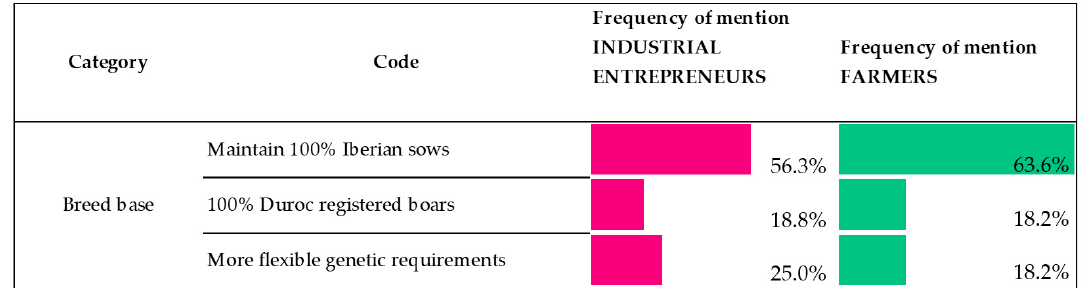
Figure 2. Industrial entrepreneur/farmer views on the requirements of the QS in terms of breed base. (Scale: frequency of mention of each opinion. Percentage is based on responses in the given code out of all responses to equal 100%) .